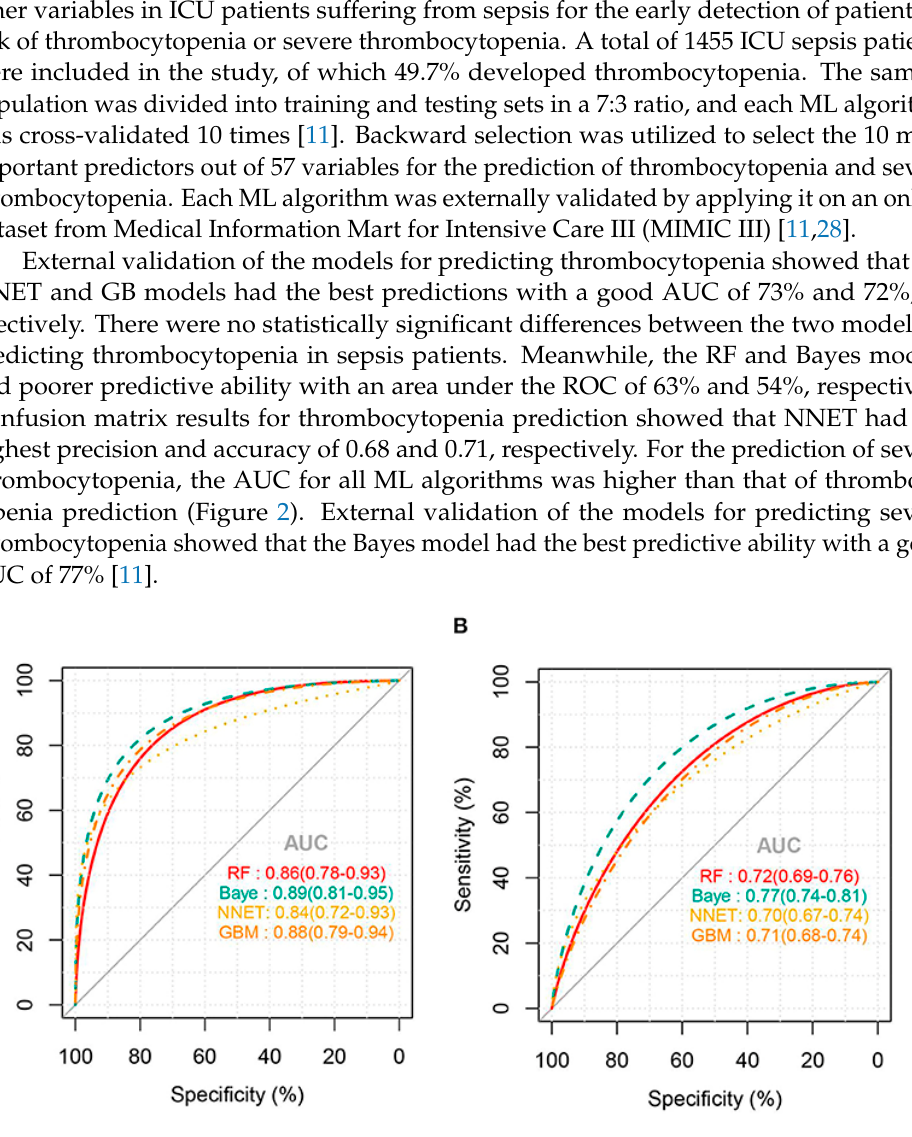
Figure 2. AUC for ML models predicting severe thrombocytopenia: ( A ) internal validation and ( B ) external validation (Jiang, X. et al. 2022)